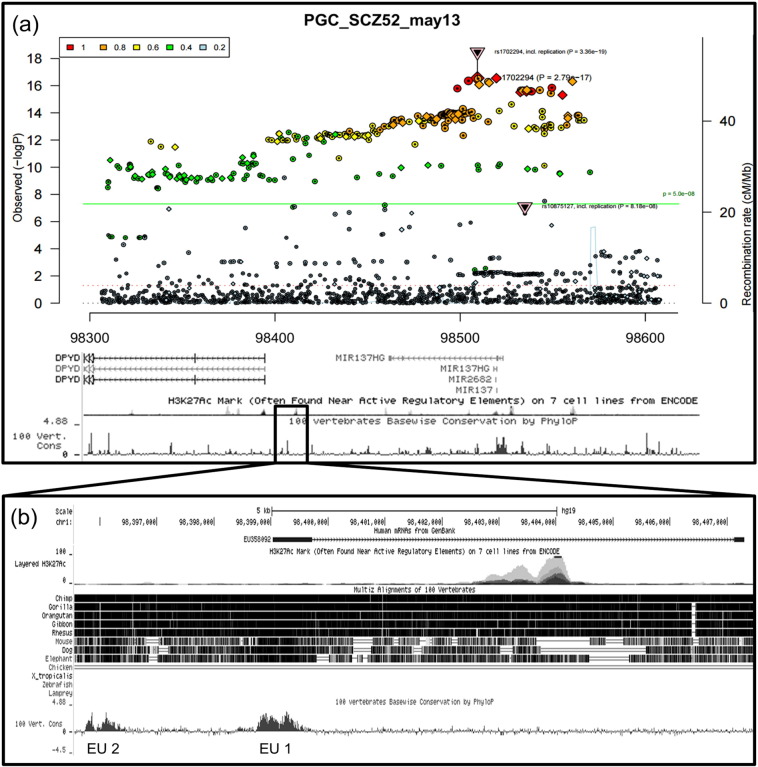
Chromosome 1p21.3 genome wide schizophrenia-associated locus.(a) A composite figure overlaying data across the MIR137 and DPYD genes at chr1:98,300,000–98,600,000 (GRCh37/hg19). The Psychiatric Genomics Consortium's May 2013 schizophrenia GWAS data (PGC SCZ52) was overlaid with H3K27Ac histone marks and evolutionary conservation data from the UCSC Genome Browser. Points above the green line represent GWAS SNPs with a statistically significant P-value of 5.0 × 10− 8 or more, demonstrating high genome-wide association for schizophrenia across the locus, which expands from MIR137 into EU358092 and the neighbouring gene, DPYD. Evolutionary conservation and H3K27Ac marks over this locus are shown below, and are markers of potential conserved function and active transcriptional regulation, respectively. The region encompassing EU358092 is boxed and expanded in (b).(b) The EU358092 boxed region in (a) is expanded, showing more clearly the peak of H3K27Ac histone modifications, and presenting sequence comparison between multiple species, identifying two evolutionary conserved regions which are displayed as peaks named EU1 and EU2. EU1 overlaps the first exon of EU358092, and EU2 is approximately 2.6 kb upstream of the predicted transcriptional start site of EU358092. The locations of EU1 and EU2 indicate that they may exert regulatory effects on the EU358092 promoter.